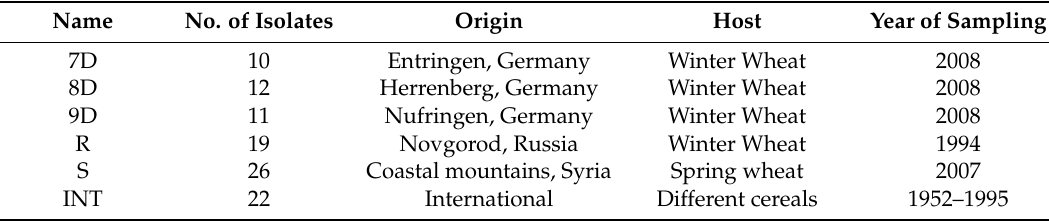
Table 1. Population name, number of isolates, origin, host and year of sampling of the Fusarium culmorum populations used for